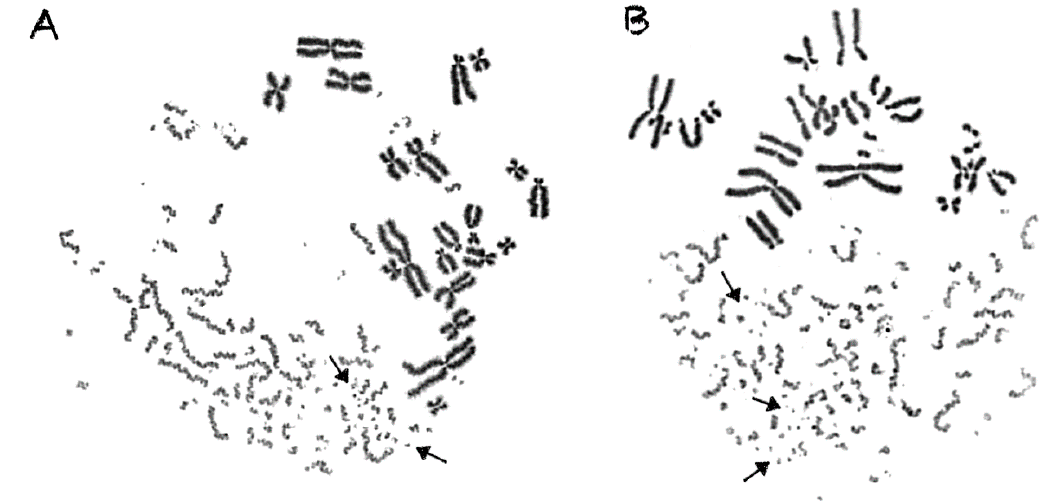
Figure 3. High-LET particle irradiation induces localized chromosome shattering, as revealed in G0 lymphocyte PCC spreads. For analysis and quantification purposes regarding the impact of particle radiation-induced clustered DNA lesions at the level of interphase chromosomes, we define localized shattered chromosome domains as the fragmentation of an interphase chromosome into five or more clearly detectable fragments in close proximity to each other. Examples are shown by arrows for a G0 lymphocyte spread obtained following exposure to 6 Gy of accelerated C-ions ( A ) and 4 Gy of protons ( B ). It is apparent that the non-targeted chromosome domains remain intact.